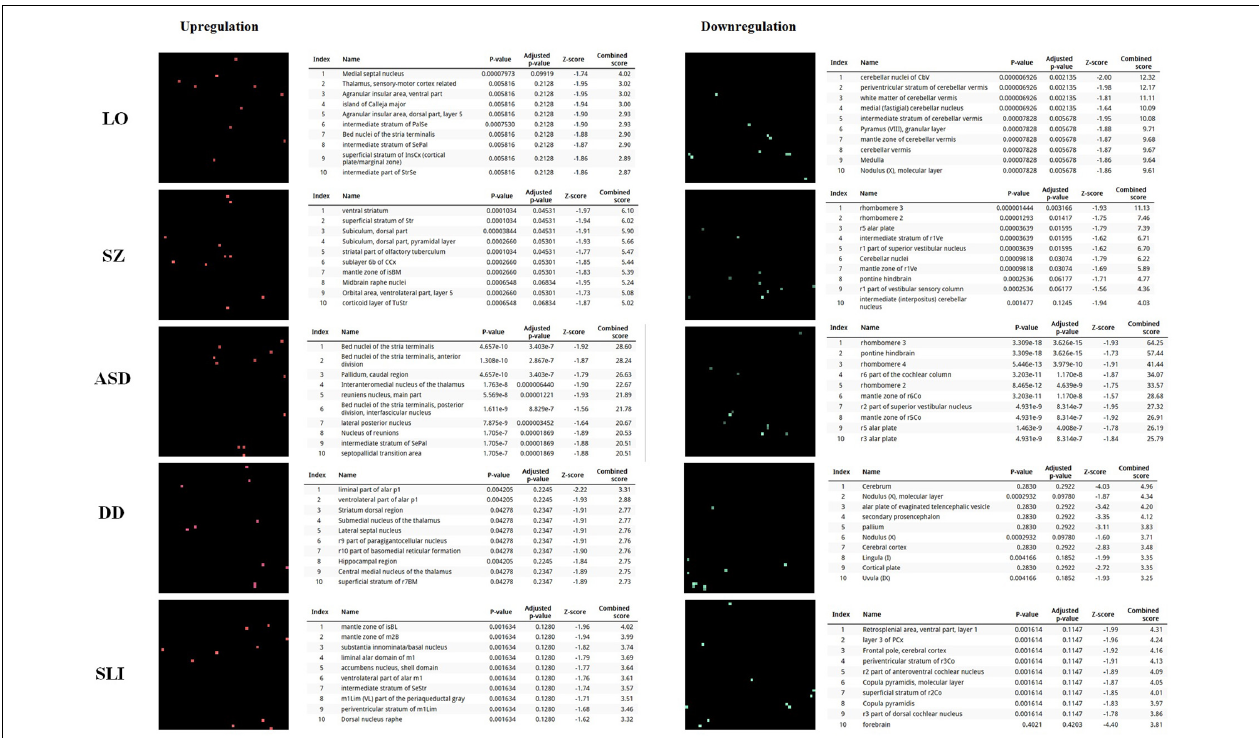
FIGURE 2 | Expression profiles in the brain of the set of genes considered in this study. Expression grids were generated with Enrichr. Brain regions where genes are most upregulated are displayed in red, whereas region in which genes are most downregulated are shown in green (the more light the color, the more up- or downregulated a gene is). The tables contain the most up- or downregulated genes according to the Combined Score. The acronyms for the brain regions are from the Allen Brain Atlas and can be checked at developingmouse.brain-map.org/docs/Legend_2010_03.pdf.